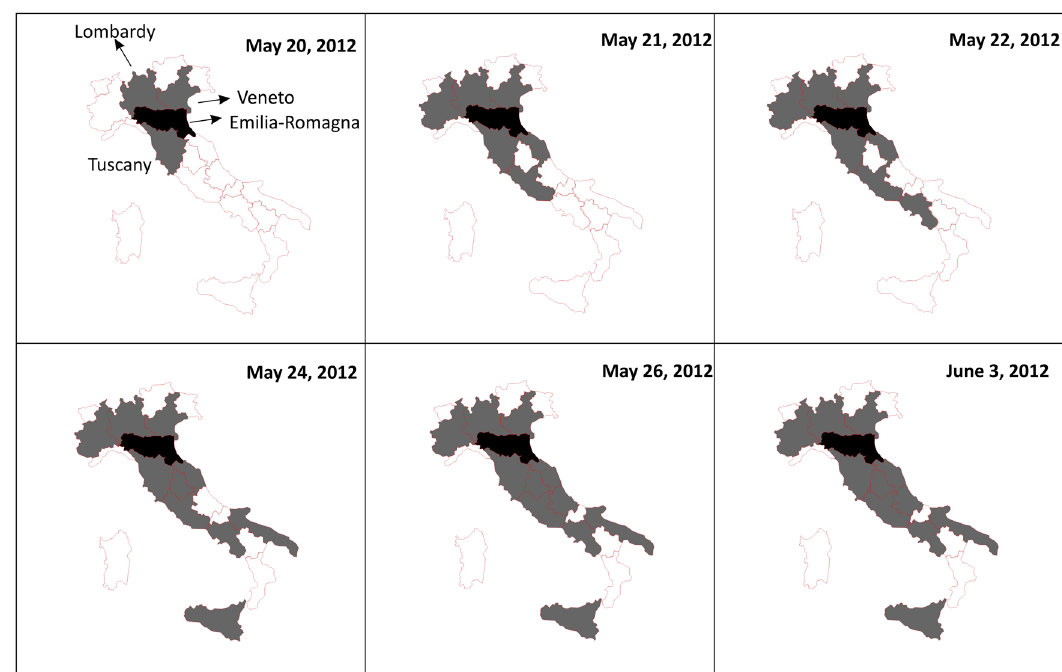
Fig. 3 2012 Emilia earthquake. Spread of ATR internet searches over the Italian regions from May 20 to June 3,